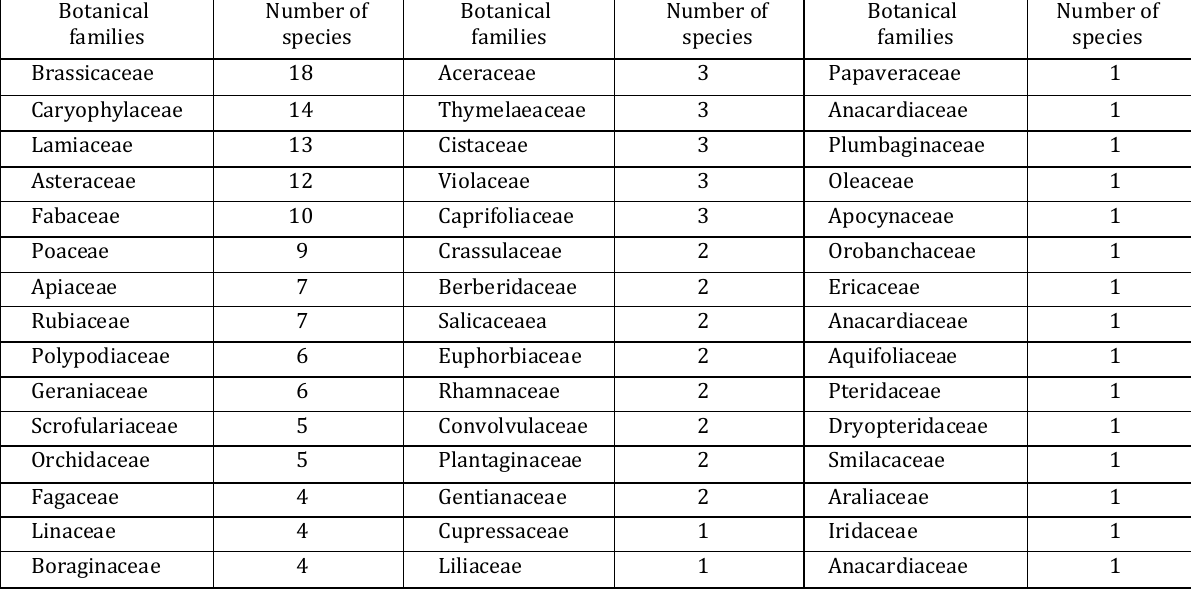
Table 2. Distribution of species in the Guerrouche Forest by botanical families